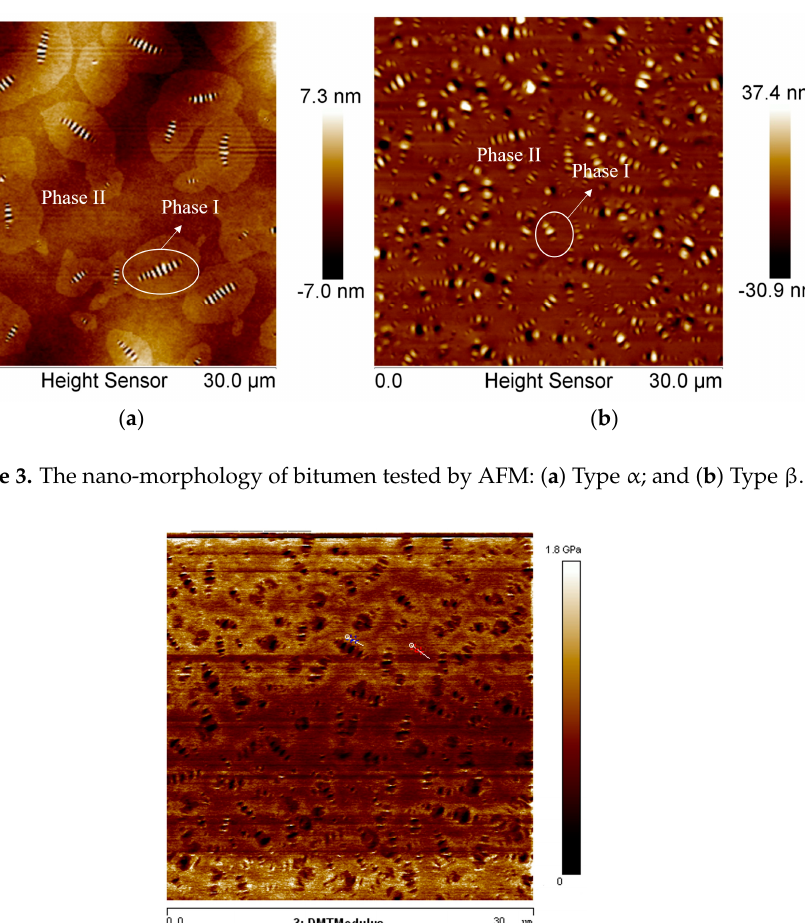
Figure 4. DMT modulus of bitumen characterized by AFM.